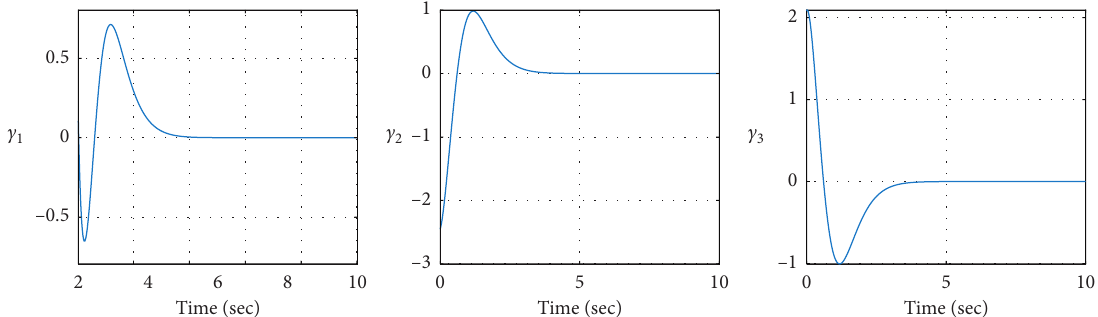
Figure 5: Changing of the fuzzy parameters ( c